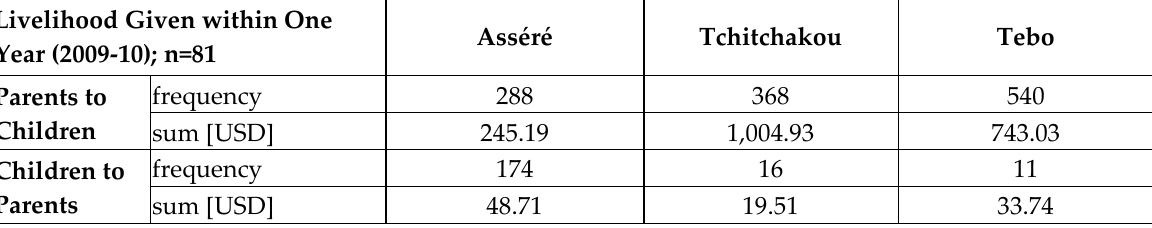
Table 1: Given Livelihood for the Parents-Children